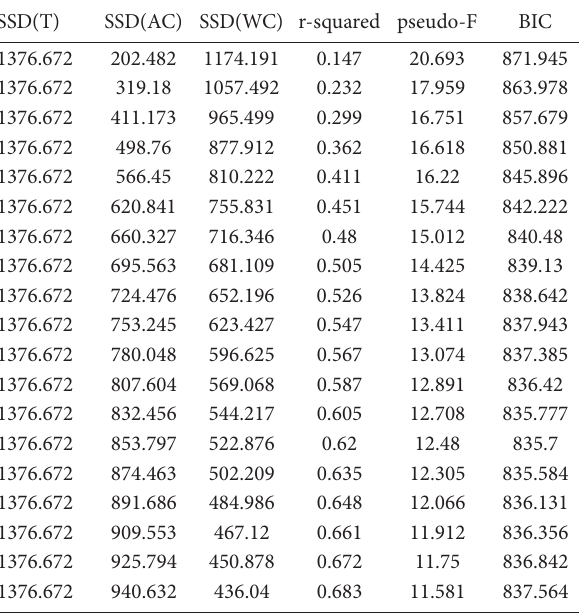
Table S5. Pair-wise AMOVA showing significant genetic differ- ence between the studied date palm cultivars (cultivar numbers are according to Table S3).